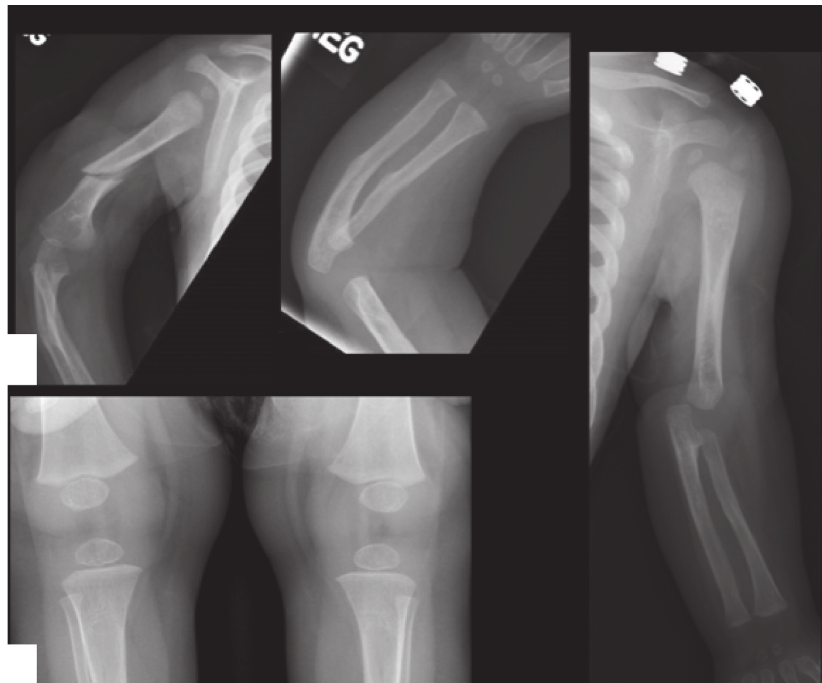
Figure 1: Spiral fracture of the right humerus is present (a). A right forearm radiograph shows healed midshaft fractures of the radius and ulna (b). The left upper extremity radiograph shows midshaft sclerosis and subtle cortical irregularity of the humerus, radius, and ulna, suggestive of healed fractures (c). The bone density is normal and no rarefaction of the zones of provisional calcification is present in the wrist and knees